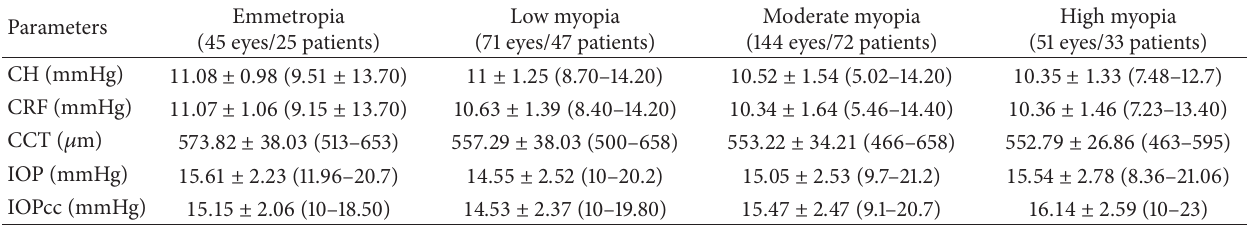
Table 2: Differences in corneal biomechanical parameters and CCT in the four diagnostic groups.